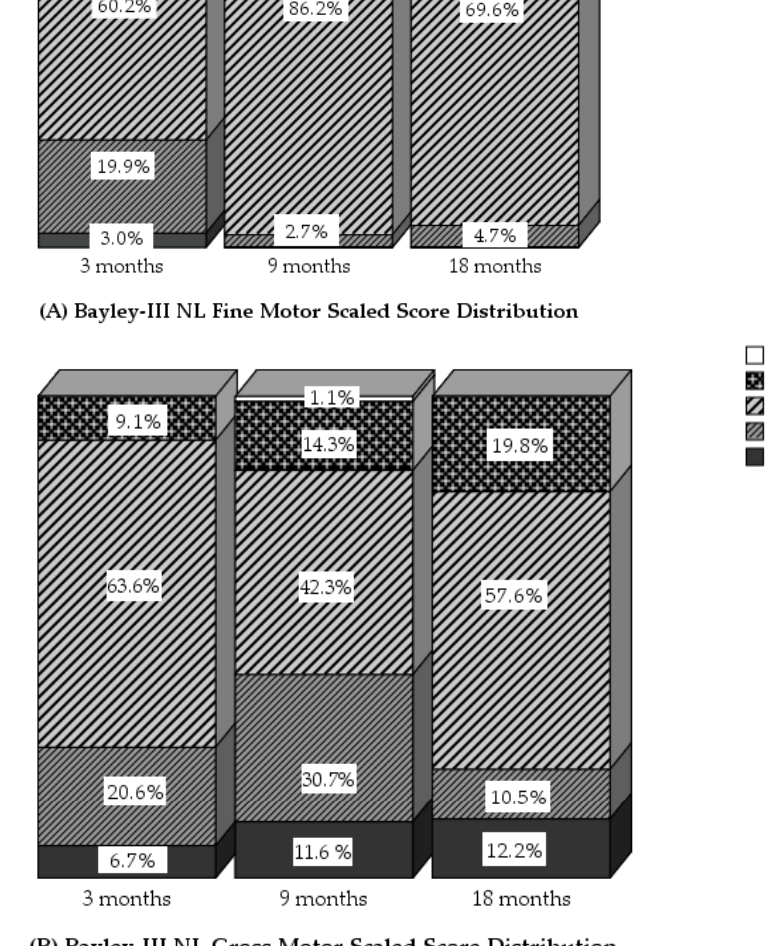
Figure 2. Bayley-III motor classifications of fine motor ( A ) and gross motor ( B ) development at 3, 9, and 18 months in children with a critical congenital heart defect (CCHD). Table 2. Motor outcomes of infants and children with a CCHD at 3, 9, and 18 months: A comparison between single-ventricle physiology (SVP) and other diagnosis groups.